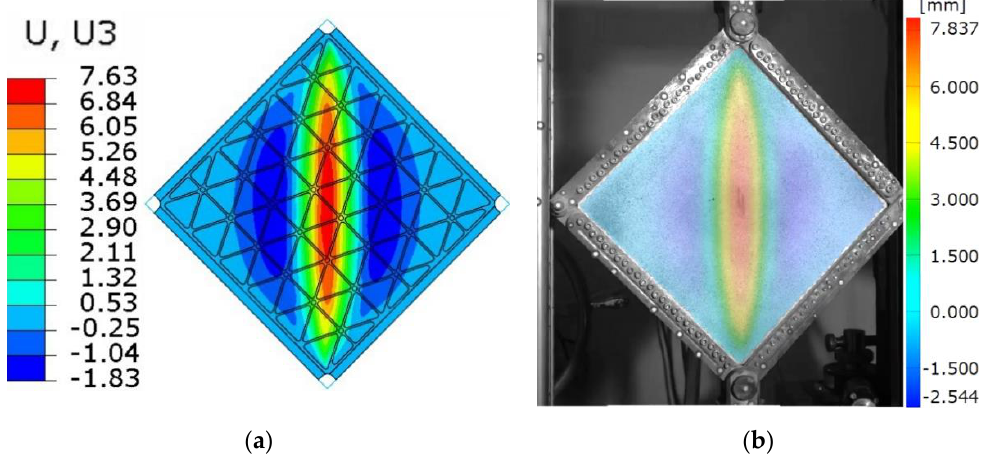
Figure 13. Quantitative comparison of the deflection field at the maximum load. ( a ) The numerical result, ( b ) the experimental DIC result.